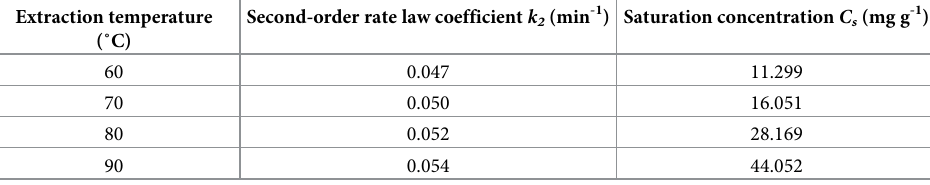
Table 2. Second-order model for the extracted EPA from N . oceanica microalgae using MAILE. Extraction temperature (˚C)